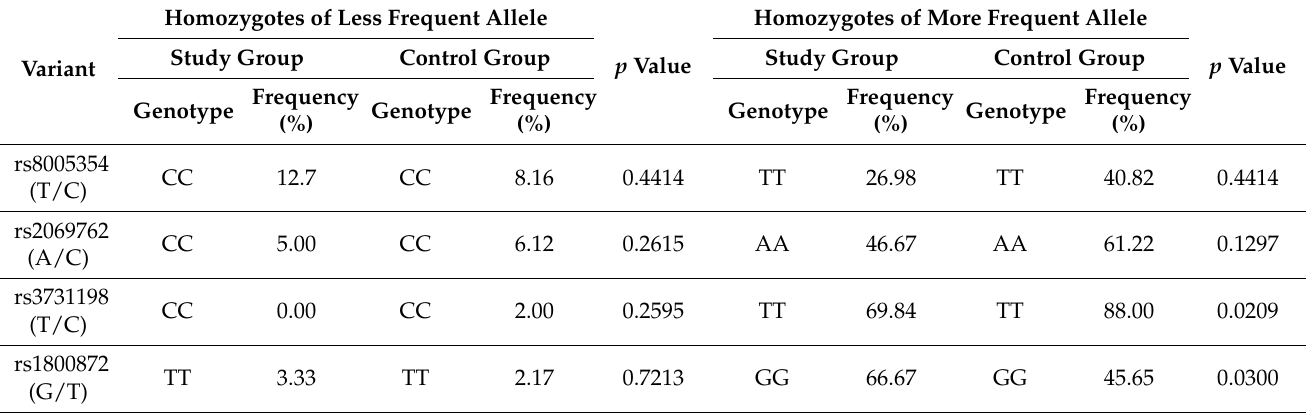
Table 3. Analysis of